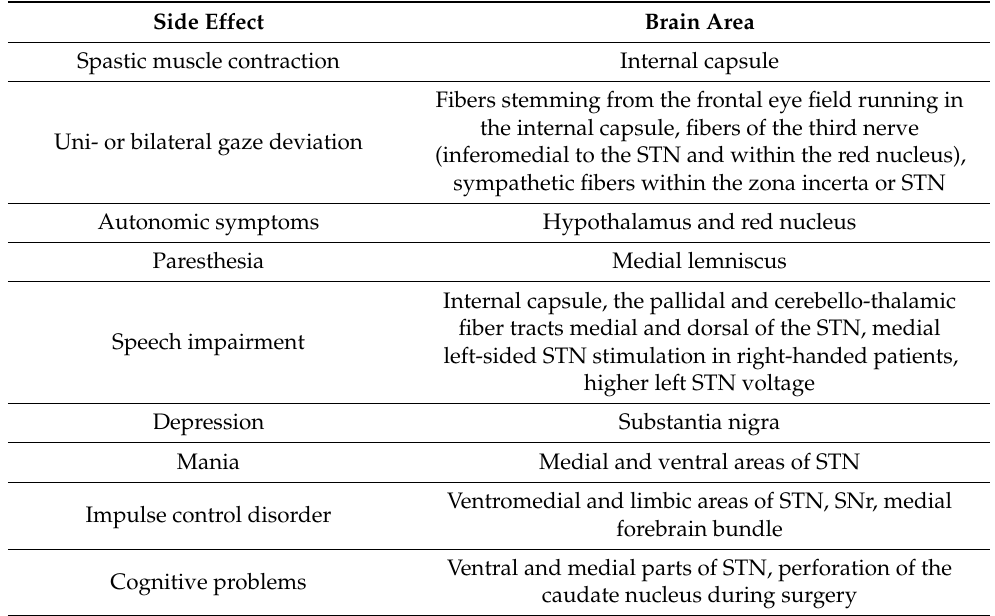
Table 6. Side effects and the brain area surrounding STN, which stimulation may be responsible for the appearance of